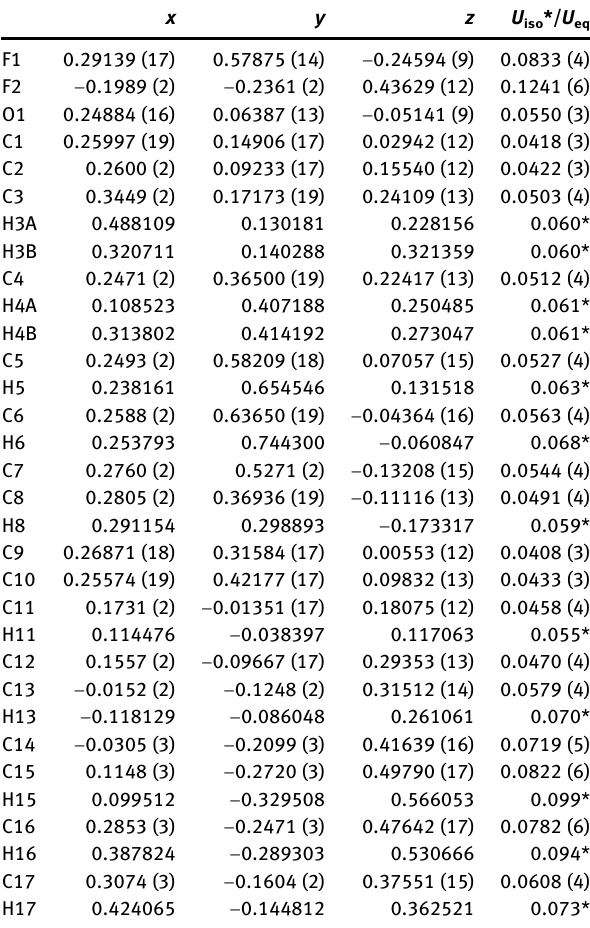
Table  : Fractional atomic coordinates and isotropic or equivalent isotropic displacement parameters (Å 